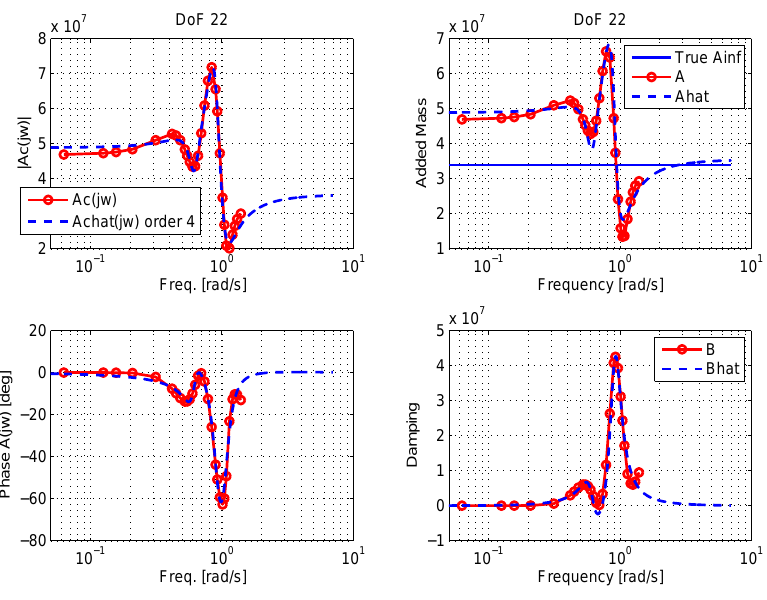
Figure 4: Fitting results for the semi-submersible. Left column: Frequency response ˜ A 33 ( jω ) and estimate. Right column: Reconstruction of added mass and damping from the identified fluid memory function ˆ K 33 ( jω ) based on an 10th order